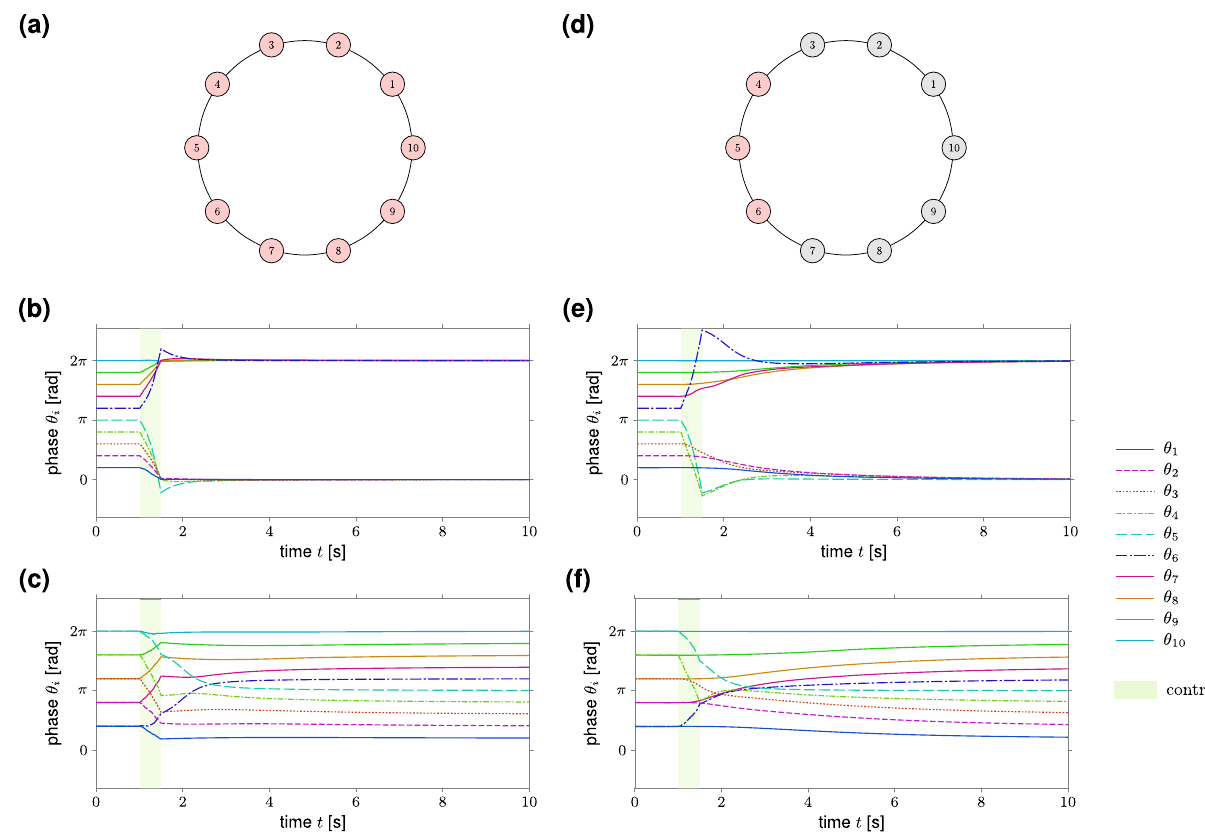
Fig. 4 Data-driven control of synchronized patterns in a ring of Kuramoto oscillators. We consider a ring network of n = 10 Kuramoto oscillators for two different con fi gurations of control nodes (red nodes), namely m = 10 ( a ) and m = 3 ( d ). For both con fi gurations, we apply the data-driven control (Eq. (4) of the main text) to steer the phases from the splay state f (cid:2) θ 1 ; i ð t Þg to the synchronous state ( b , e ) and from the splay state f (cid:2) θ 2 ; i ð t Þg to f (cid:2) θ 1 ; i ð t Þg ( c , f ). The green region denotes the application of the control. We choose as parameters T = 50 samples of the discretized dynamics (corresponding to a control horizon of 0.5 s), Q = 5 I , R = I , and N = 1000 data obtained by perturbing the initial equilibrium with i.i.d. Gaussian inputs with zero mean and standard deviation